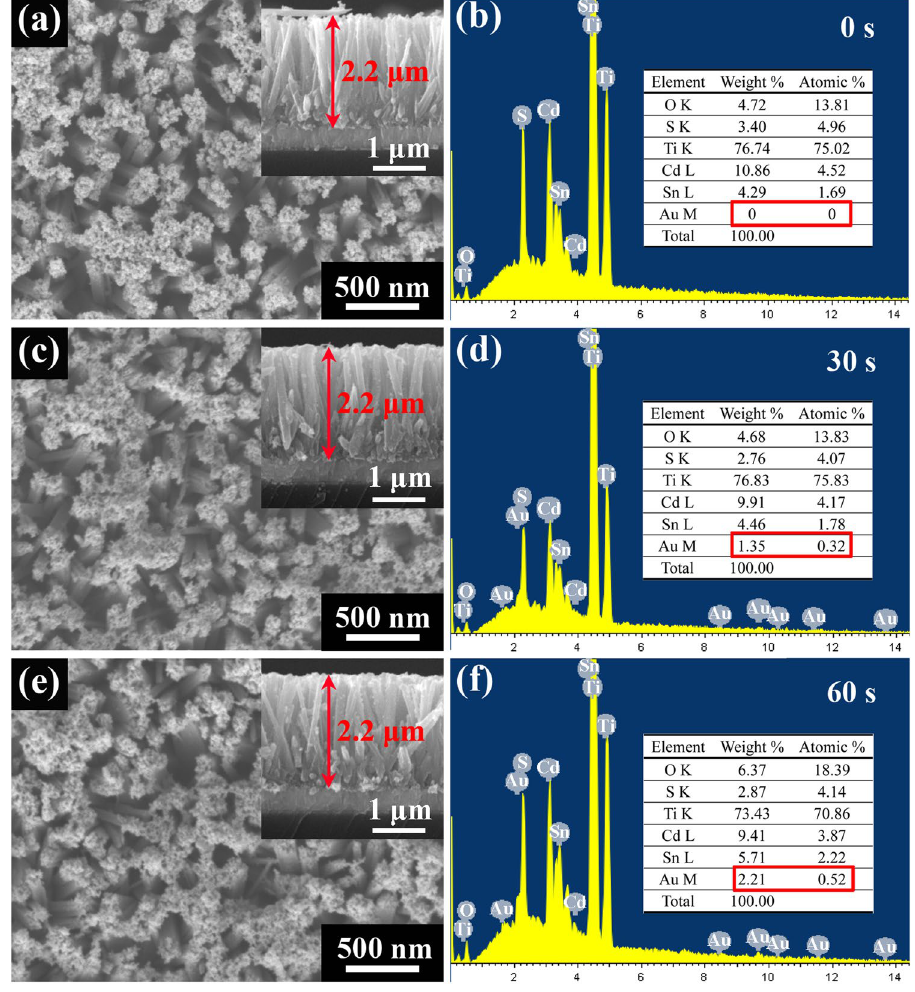
Figure 2. SEM and EDS images of TiO 2 NRAs/CdS/Au samples: ( a and b ) 0 s, ( c and d ) 30 s, ( e and f ) 60